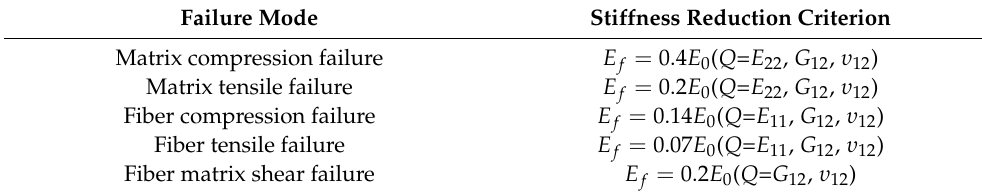
Table 5. Stiffness reduction criterion.